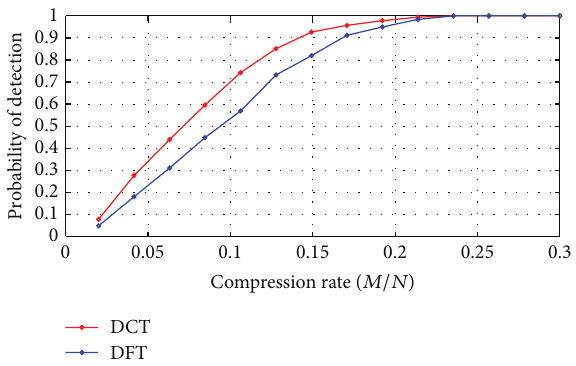
Figure 5: Probability of detection for DCT-CSS and DFT-CSS.